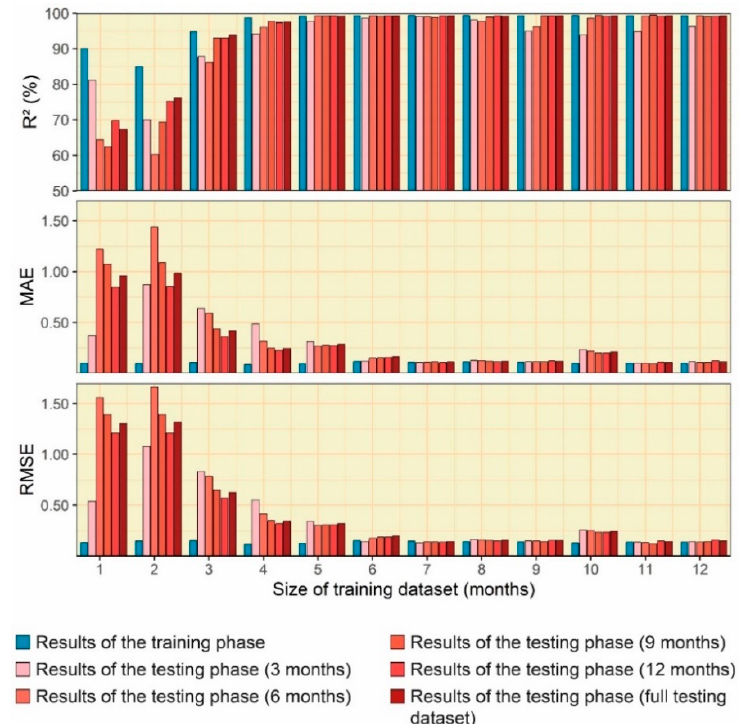
Figure 9. Influence of the size of the training sample on the MLP model (approach 1).